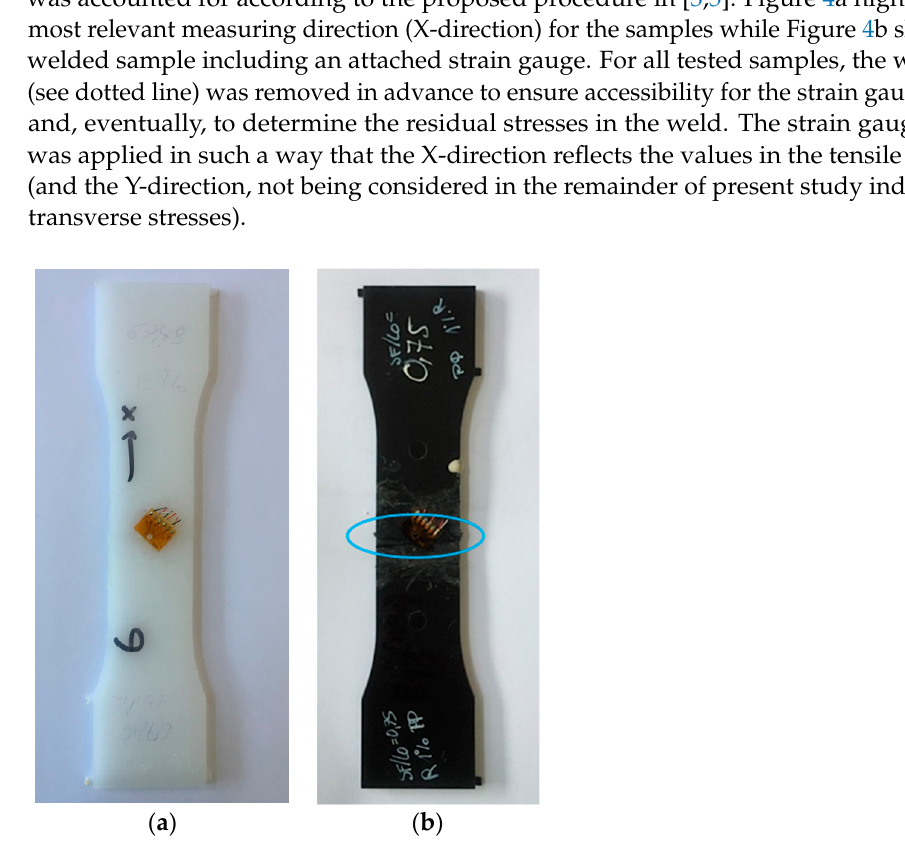
Figure 4. ( a ) Most relevant direction of the residual stress measurement and ( b ) photograph of a welded sample including an attached strain gauge and marking of the area considered in the fol- lowing investigations